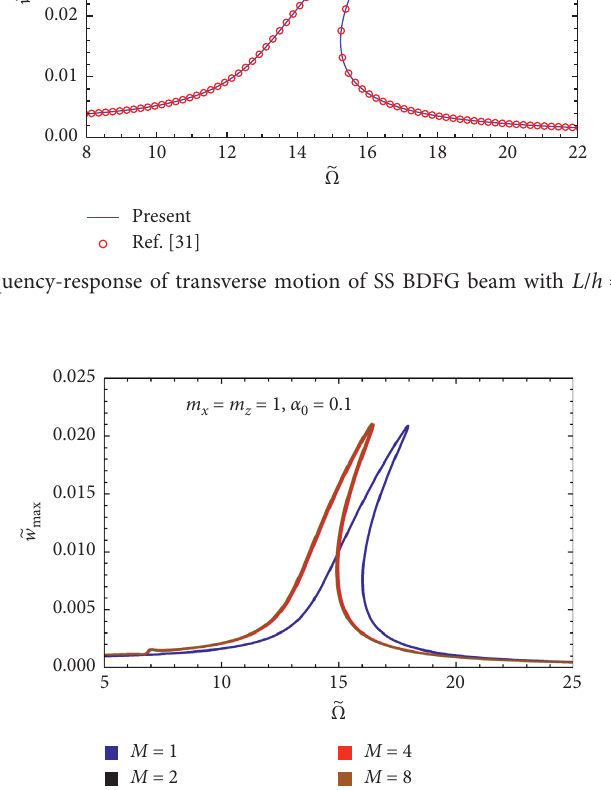
Figure 3: Convergence of the reduce order model for the nonlinear vibration analysis of SS BDFG porous